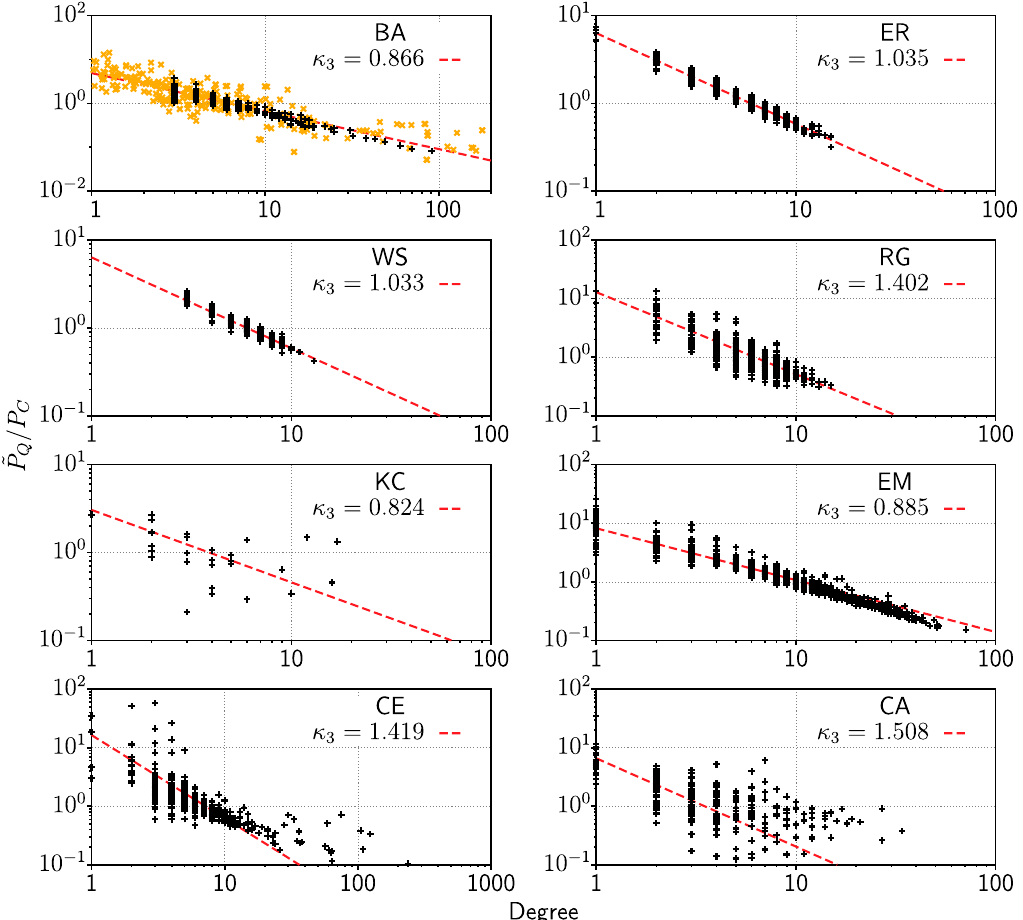
~ P P Q Þ i and classical ð C Þ i probabilities plotted against degree